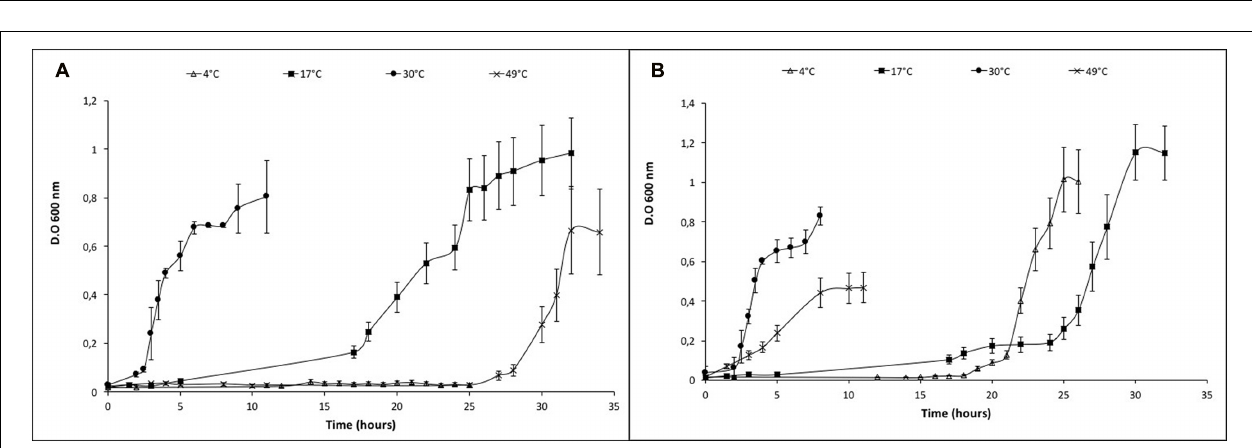
FIGURE 1 | Adaptation growth curves of Vibrio sp. in presence of NaCl. Vibrio sp. cells were adapted previously to grow in presence of 0 g/L NaCl and KCl ( (cid:4) ), 25 g/L NaCl (